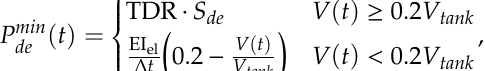
Table 3. Energy intensity (EI) and turndown ratio (TDR) of desalination technologies. Desalination EI el [kWh / m 3 ] Ref. EI th [kWh / m 3 ] Ref. TDR Ref. MED 2.50 53.20 MSF 4.17 MVC 12.41 RO 4.35